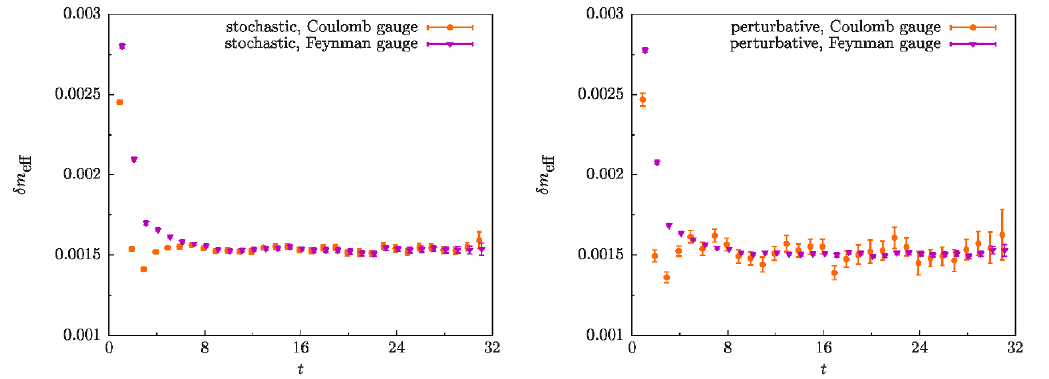
Figure 20 . Comparison of the QED correction to the e(cid:11)ective mass of a charged kaon between Feynman (purple triangles) and Coulomb (orange circles) gauge. The plot on the left shows data from the stochastic method, the plot on the right data from the perturbative method. Note, that the results for the Coulomb gauge with the perturbative method have been obtained on a subset of the